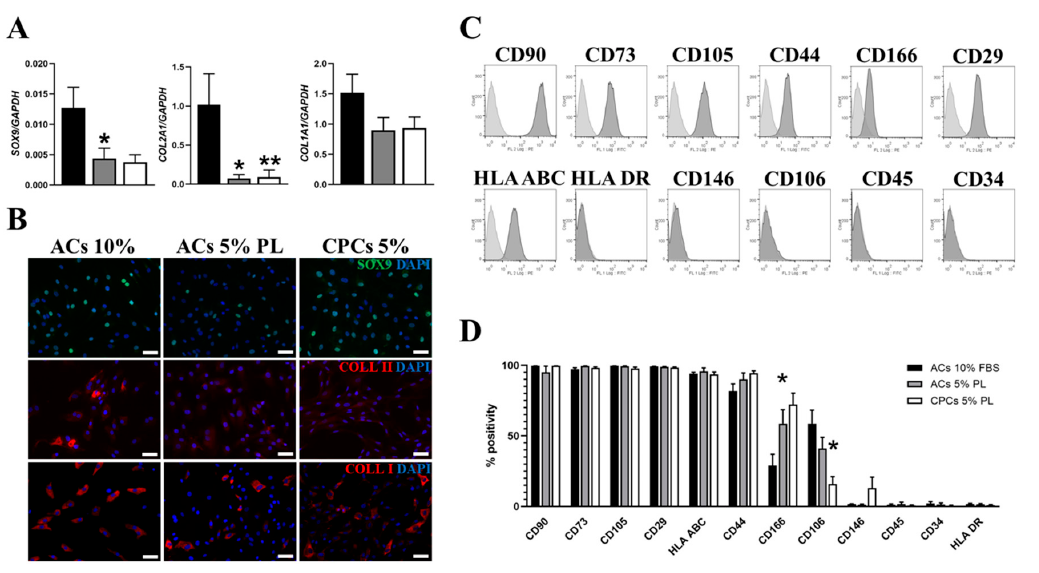
Figure 3. Analysis of chondrogenic and cell surface markers in ACs-FBS, ACs-PL and CPCs-PL. ( A ) Expression profile of the chondrogenic markers SOX9 , COL2A1 and COL1A1 in ACs 10% FBS, ACs 5% PL and CPCs 5% PL determined by qRT-PCR. Data are represented as mean ± SEM ( N = 7, * p < 0.05 versus ACs 10% FBS and ** p < 0.01 versus ACs 5% PL by Mann–Whitney test analysis). ( B ) Immunofluorescence staining for SOX9 (upper panel), type II collagen (middle panel) and type I collagen (bottom panel) in the three experimental groups. ( C ) Representative flow cytometry characterization of CPCs for a set of typical surface markers: light grey peaks indicate the isotype control staining and dark grey peaks indicate the antibody staining. ( D ) Histogram reporting the percentage of positive ACs 10% FBS, ACs 5% PL and CPCs 5% PL for each tested marker in flow cytometry experiments; data are represented as mean ± SEM ( N = 3, * p < 0.05 versus ACs-FBS for CD166 and versus ACs-PL for CD106 by Student’s t -test analysis). All scale bars correspond to 100 µm.